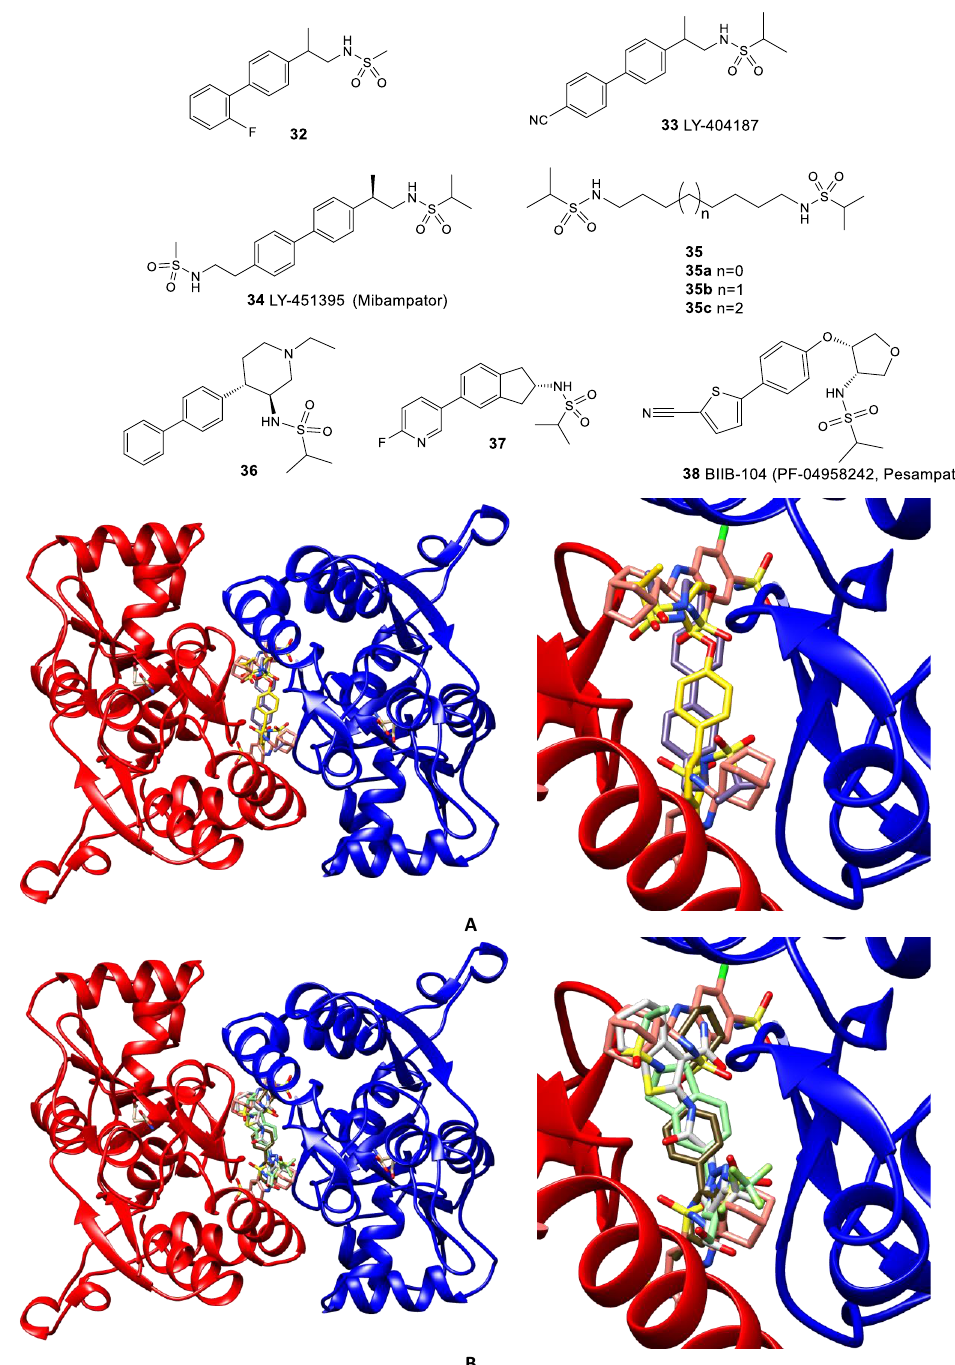
Figure 7. Comparison of the binding modes of AMPA receptor positive allosteric modulators in the dimeric LBD of GluA2. ( A ) cyclothiazide ( 26 , salmon, PDB: 3TKD), LY-451395 ( 34 , pale purple, PDB: 5YBG), and BIIB-104 ( 38 , yellow, PDB: 4X48). ( B ) cyclothiazide ( 26 , salmon, PDB: 3TKD), JAMI1001A ( 41 , light grey, PDB: 4FAT), compound 43a (pale green, PDB: 3PMW), and TAK-653 ( 47 , dark olive, PDB: 7F3O). Left—general view, right—detailed binding mode. For clarity, only one symmetrically equivalent orientation is shown for each ligand. The aligned receptor subunits are shown in blue and red, and the agonist (glutamate) molecules bound in the orthosteric binding sites are shown in